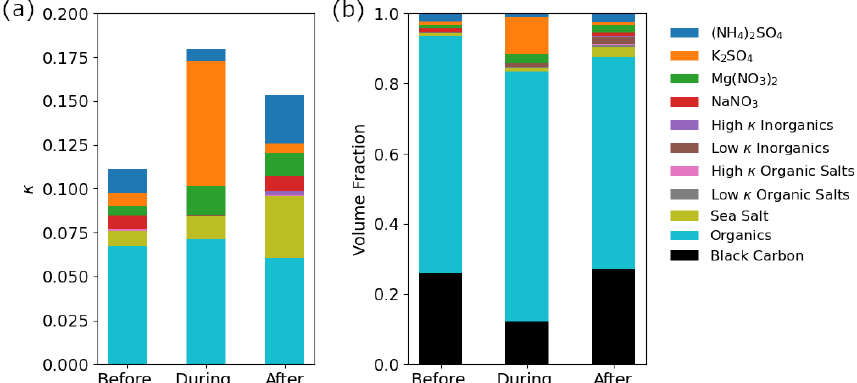
Figure 8. (a) Kappa ( κ ) values for the aerosol fraction between 0.056–3.2µm before, during, and after the firework event. The speciated contributions to the overall κ values (represented by the colors) are categorized based on the classes of compounds in the legend following past work (AzadiAghdam et al., 2019). Ammonium sulfate, K 2 SO 4 , Mg(NO 3 ) 2 , and NaNO 3 are high κ inorganics but are plotted separately because of their large contributions. The speciated contributions were calculated by multiplying the (b) volume fraction of each compound class by its intrinsic κ value (Table